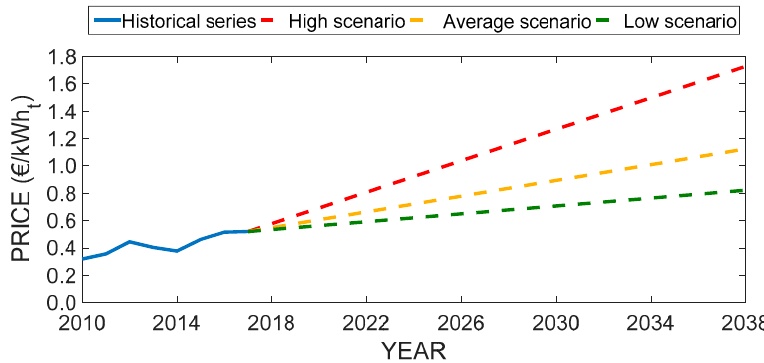
Figure 4. Natural gas price evolution and estimation from 2010 to 2038, Group I1.